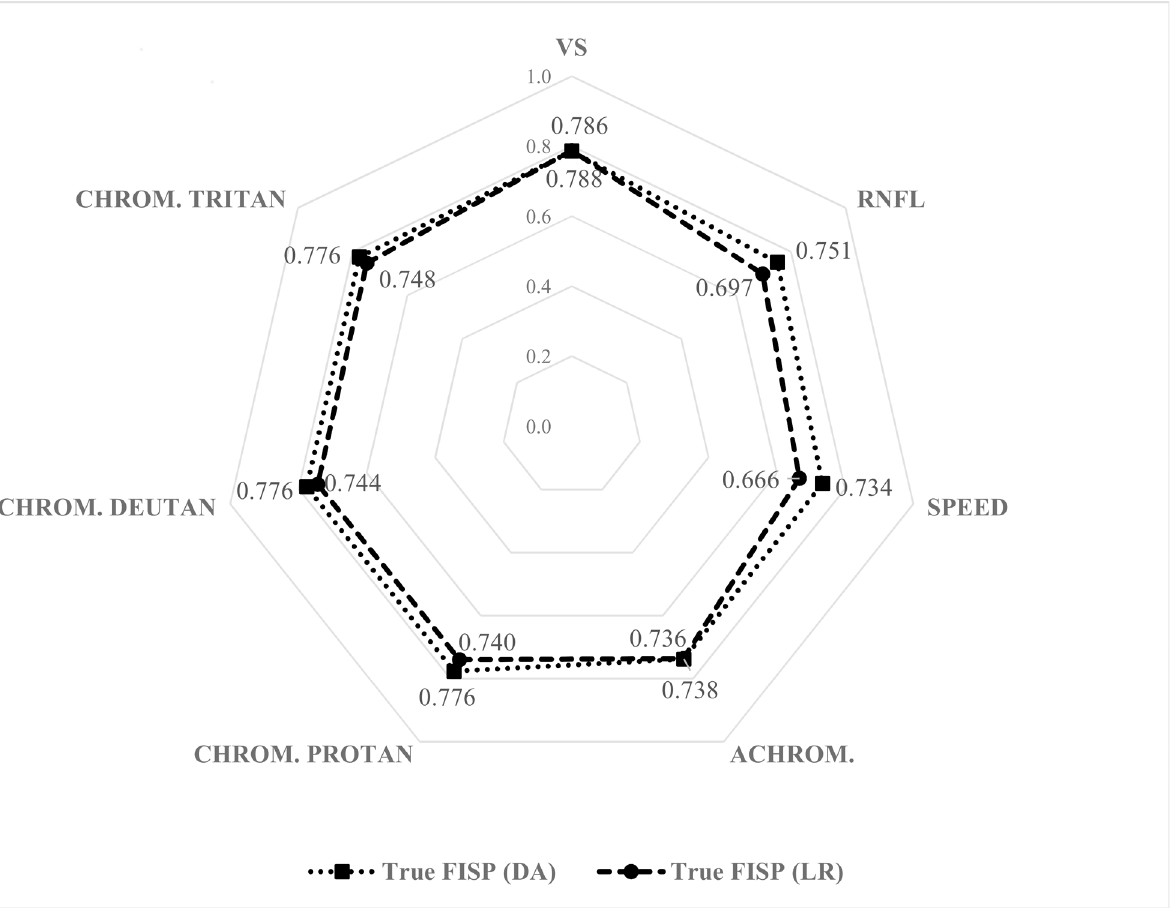
Fig 1. Correlation coefficient between True-FISP and each one of the new eye related constructs. All correlation coefficients were determined in the new derived variables, obtained either with DA or LR method, adjusted for age, gender, body mass index and blood pressure., obtained with DA and LR methods. The Spearman coefficient is presented, for each method, nearby the